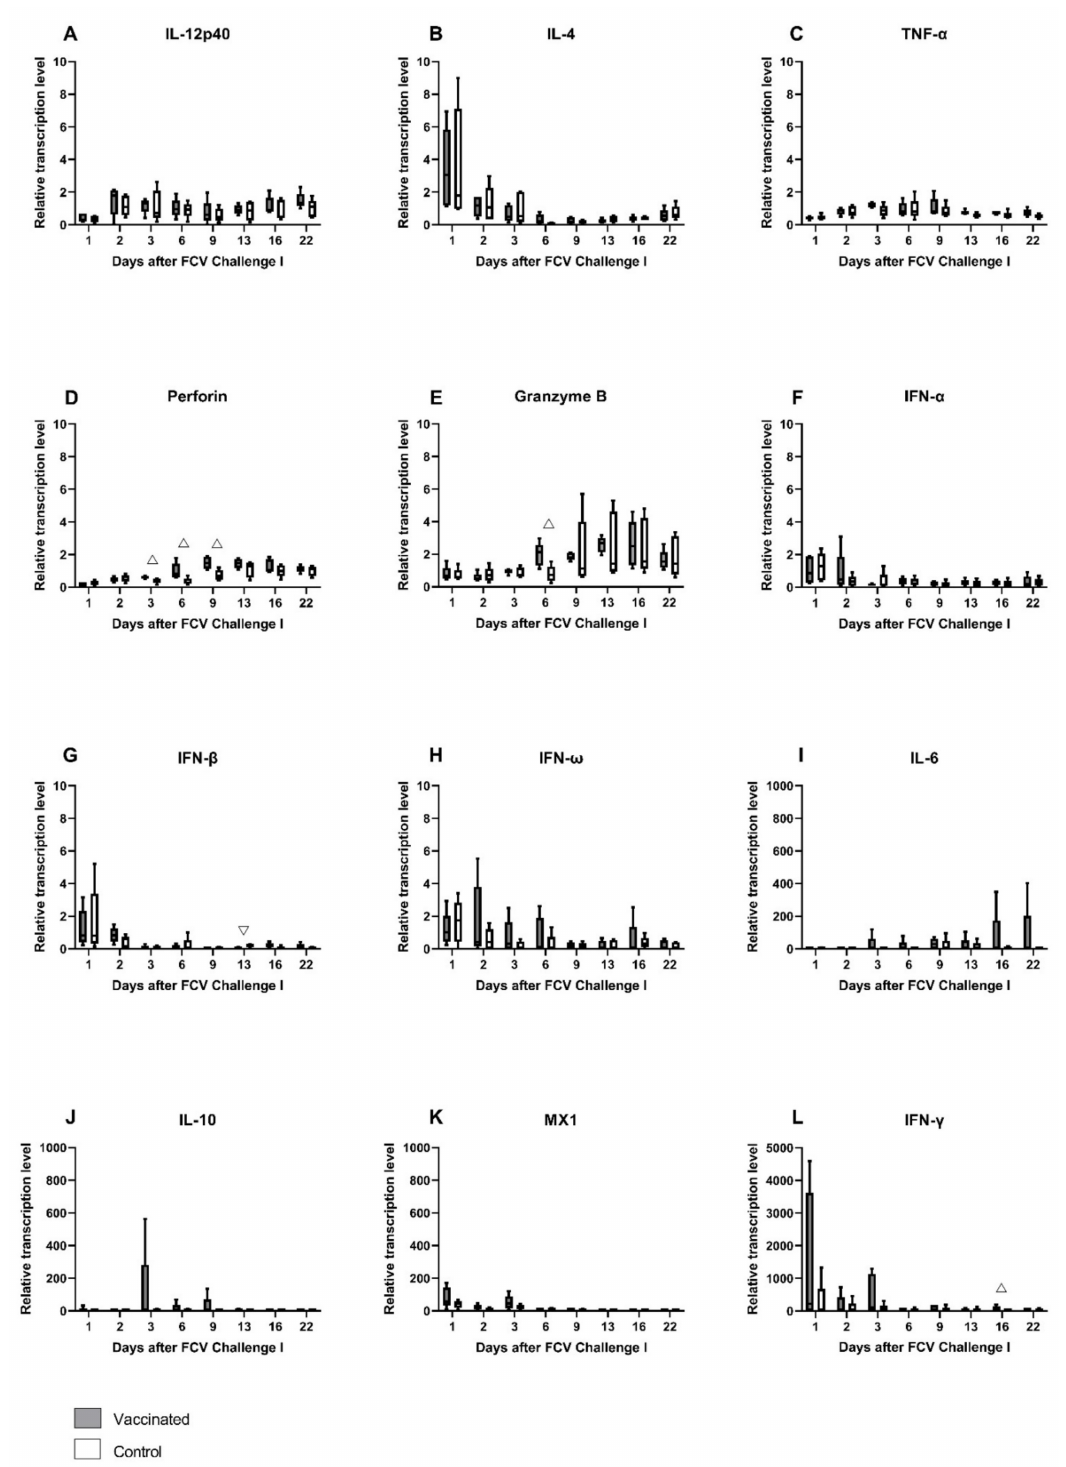
Figure 8. Box and whisker plots of cytokine expression profiles of IL-12p40 ( A ), IL-4 ( B ), TNF- α ( C ), perforin ( D ), granzyme B ( E ), IFN- α ( F ), IFN- β ( G ), IFN- ω ( H ), IL-6 ( I ), IL-10 ( J ), MX1 ( K ) and IFN- γ ( L ) after FCV Challenge I. The line inside the box shows the median, and the lower and upper border of the box indicates the 25th and 75th percentile, respectively. Whiskers represent minimum and maximum values. Significant differences between the vaccinated and the control group are indicated with an open triangle; (cid:53) denotes significantly lower in the vaccinated group P MWU ≤ 0.05; (cid:52) denotes significantly higher in the vaccinated group P MWU ≤ 0.05. The y-axes are scaled to either 0–10, 0–1000, or 0–5000 relative mRNA transcription levels, and the graphs are ordered,